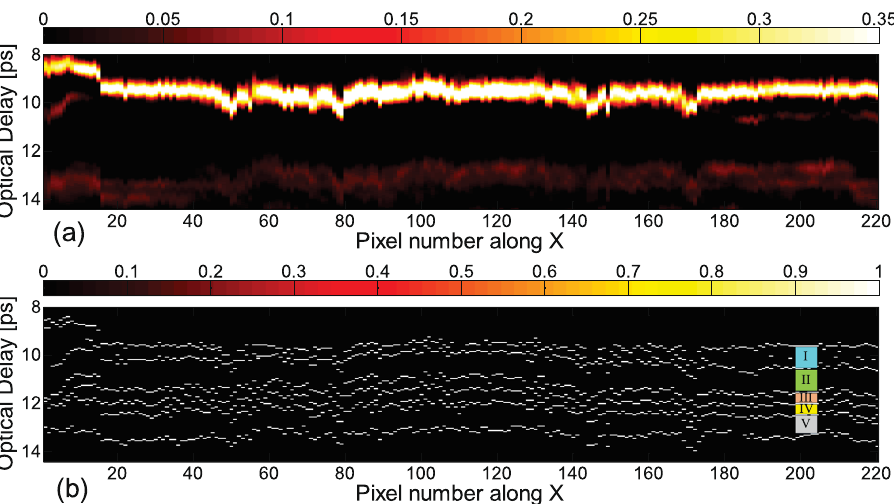
Figure 5. Comparison for optical delay corresponding to the layers above the canvas between ( a ) the THz B-scan based on the raw data (Fig. 3 on an expanded vertical scale) and ( b ) the binary THz B-scan based on the deconvolved data with the cross-section Y = 150 in which a valid peak is assigned value ‘1’ and the other positions ‘0’ regardless of the sign or height of the peak. I: varnish; II: pictorial layer; III: underpainting; IV: imprimatura; V: ground